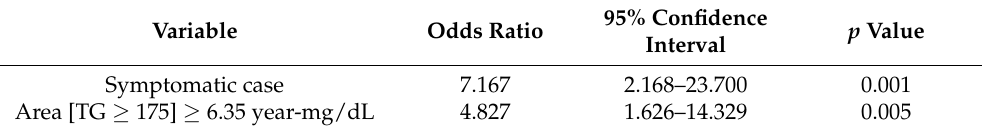
Table 3. Multivariate logistic regression analyses of clinical variables for carotid stenosis